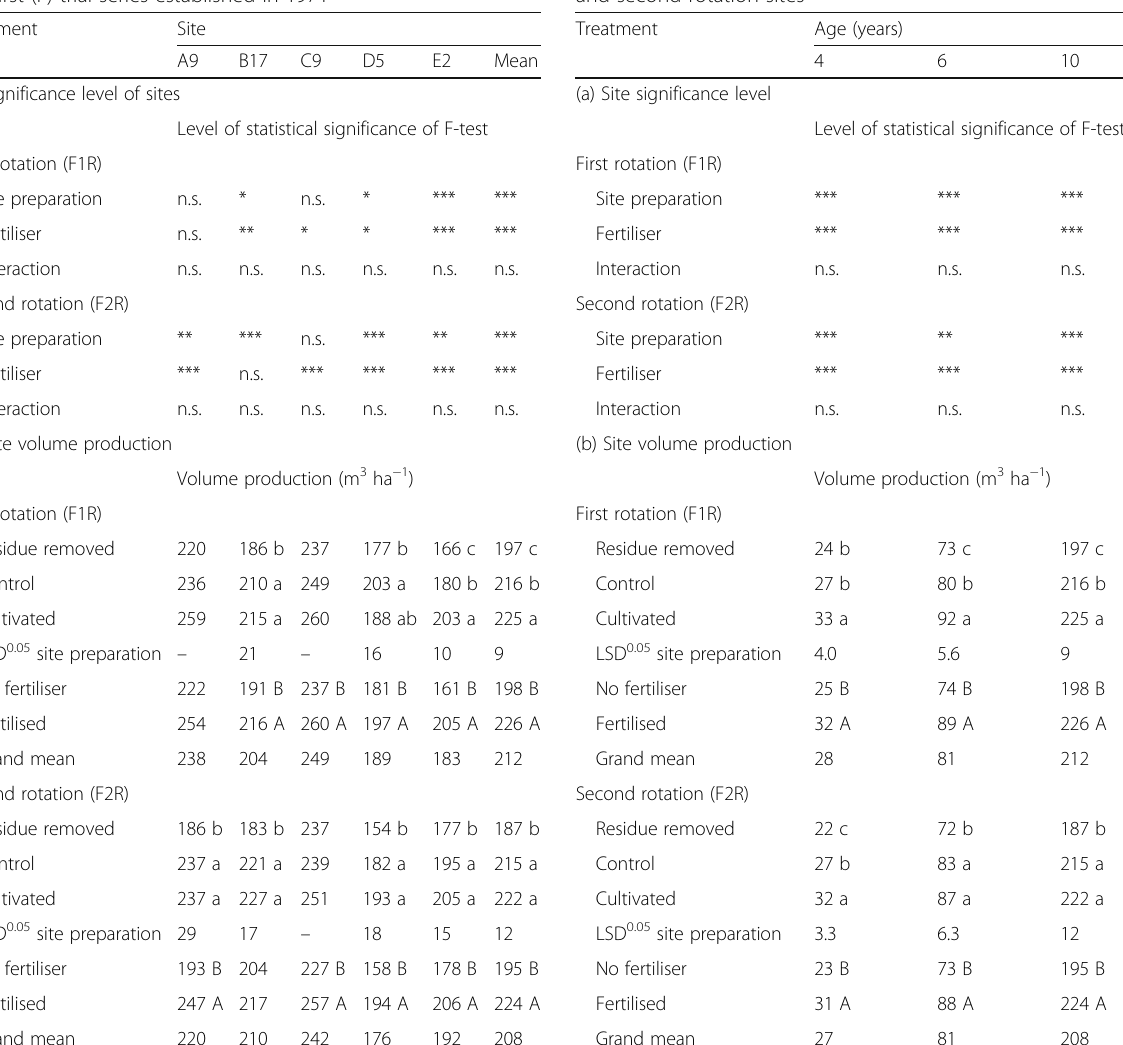
Table 4 The ANOVA summary, (a) main treatment significance level and (b) volume production per main treatment across five sites over time for the first trial series established in 1971 on first